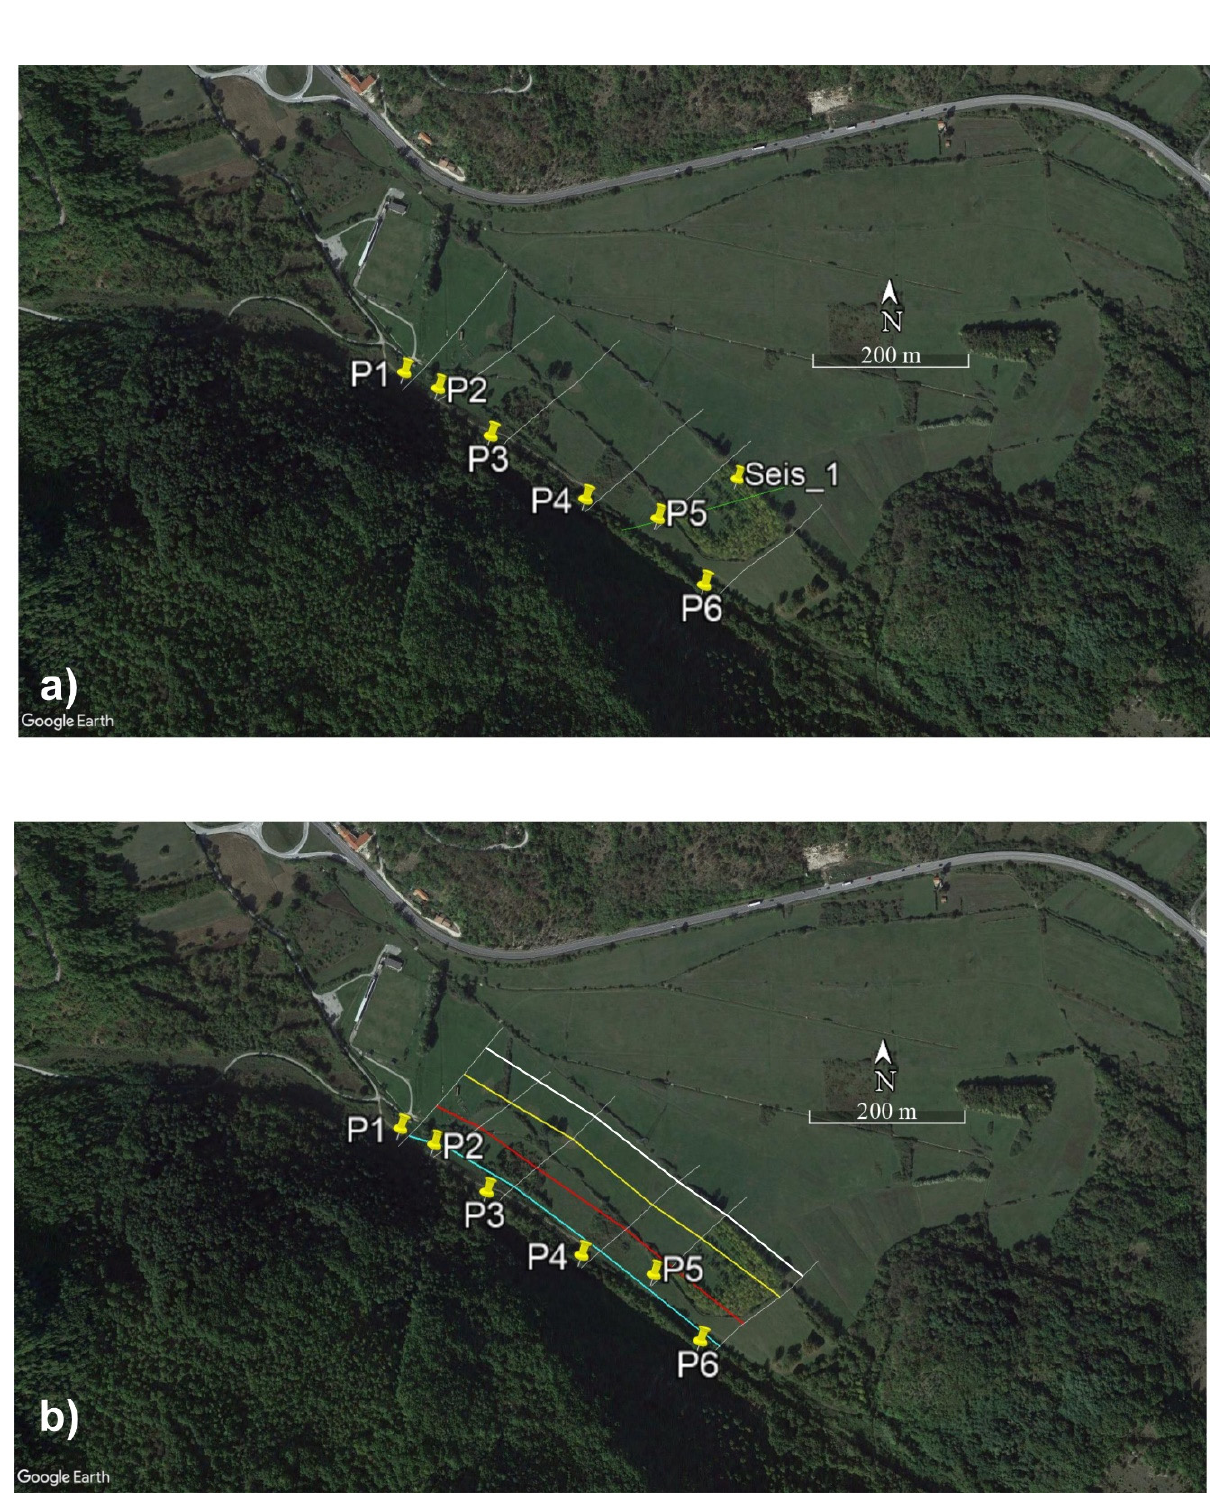
Figure 3. (a) Map of the seismic refraction (Seis_1) and GPR (from P1 to P6) profiles conducted at the “Il Lago” Plain (see the black box in Figure 2 for location); and (b) georeferenced localization of the identified structures associable to the fault system detected by GPR data. The solid light blue and yellow lines are the identified antithetic faults. The solid red and white lines are the identified synthetic faults (see Figure 13).